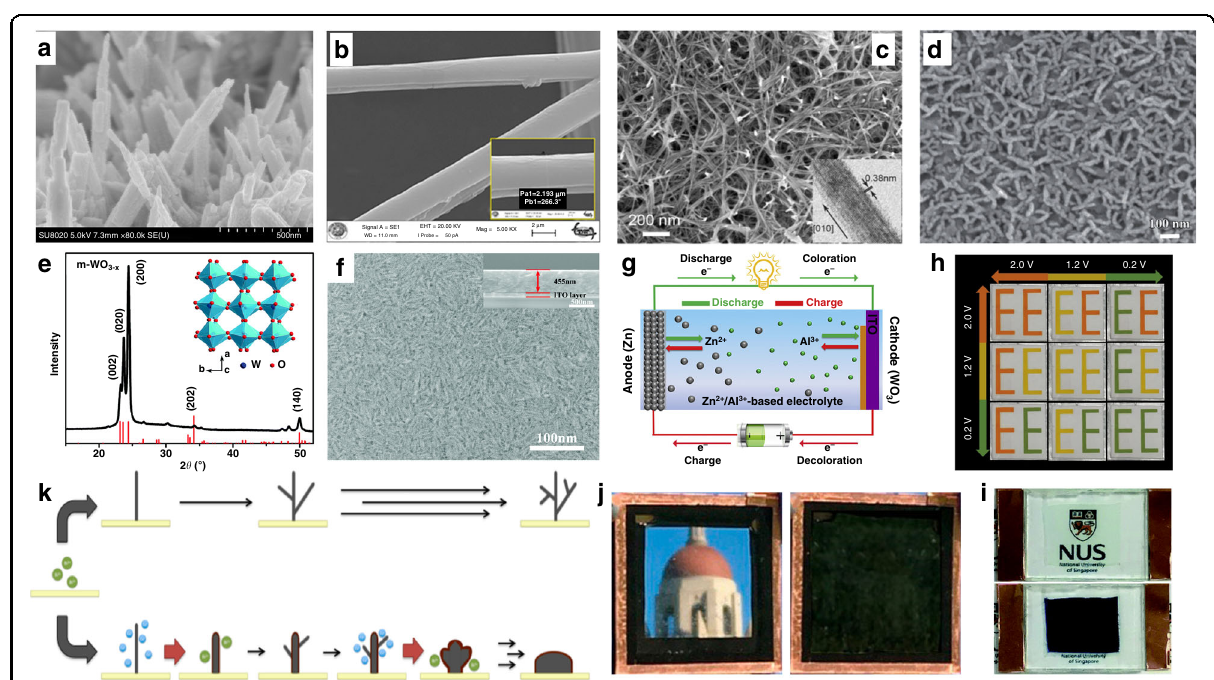
Fig. 2 Latest developments in various inorganic electrochromic materials and devices. a Scanning electron microscopy (SEM) image of WO 3 nanorods 79 . b SEM image of PPy/WO 3 /BMIMBF 4 nano fi bers 80 . c Typical SEM image of a WO 3 sample manifesting a nanowire morphology 37 . d SEM image of an electrodeposited WO 3 fi lm on ITO glass 33 . e Structure and morphology characterization of m-WO 3- x nanowires 36 . f Digital photo of an electrochromic device assembled from an m-WO 3- x nanowire working electrode 36 . g Scheme of the rechargeable hybrid Zn 2 + /Al 3 + electrochromic battery 17 . h Multicolor electrochromic display based on a SVO electrode 38 . i Electrochromic device assembled by an m-WO 3- X nanowire working electrode and an ITO glass counter electrode 36 . j Hybrid dynamic windows using reversible metal electrodeposition 42 . k Reaction schematic showing the electrodeposition of Bi in the absence and presence of Cu. Green and blue circles represent Bi 3 + and Cu + ions participating here